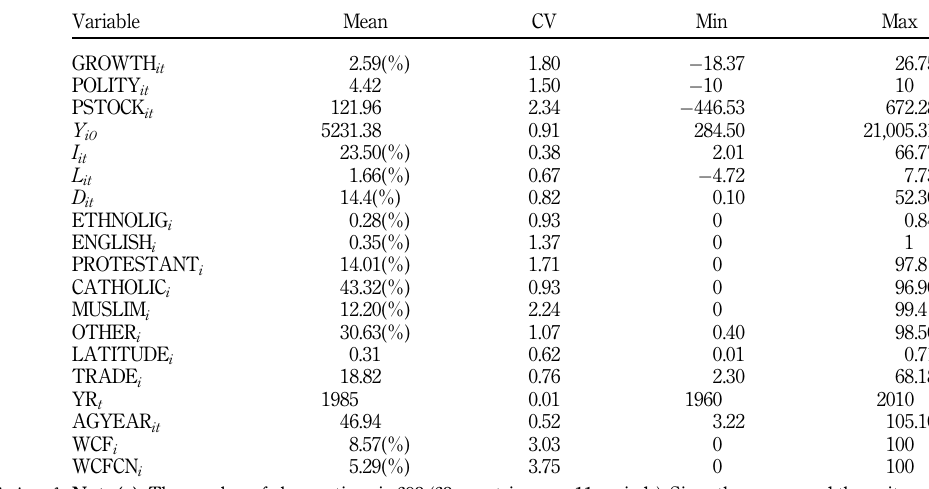
research variables